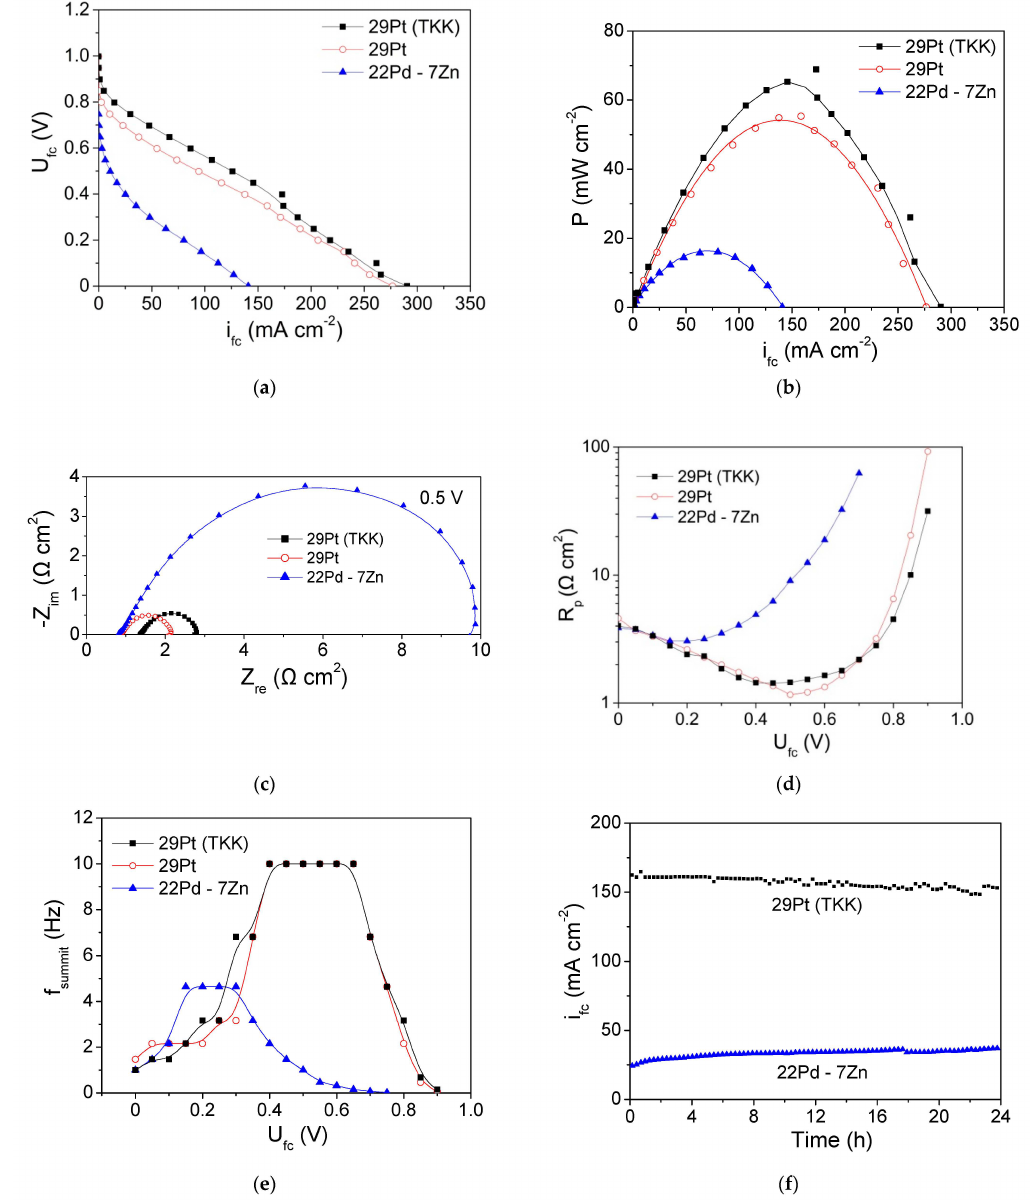
Figure 8. Comparison of the performance of the tested PEMFCs: ( a ) Cell potential ( U fc ) vs. current density ( i fc ) curves. ( b ) Power density ( P ) vs. current density ( i fc ) curves. ( c ) EIS characteristics (Nyquist plots) at 0.5 V. ( d ) Apparent polarization resistance ( R p ) vs. cell potential (U fc ) plots. ( e ) Summit frequency ( f summit ) vs. cell potential ( U fc ) plots. ( f ) Current density ( i fc ) vs. time for 24 h operation under 0.4 V. Flow rates: F anode (100% H 2 ) = F cathode (synthetic air) = 100 cm 3 min − 1 ; geometric electrode surface area, A elec = 5.29 cm 2